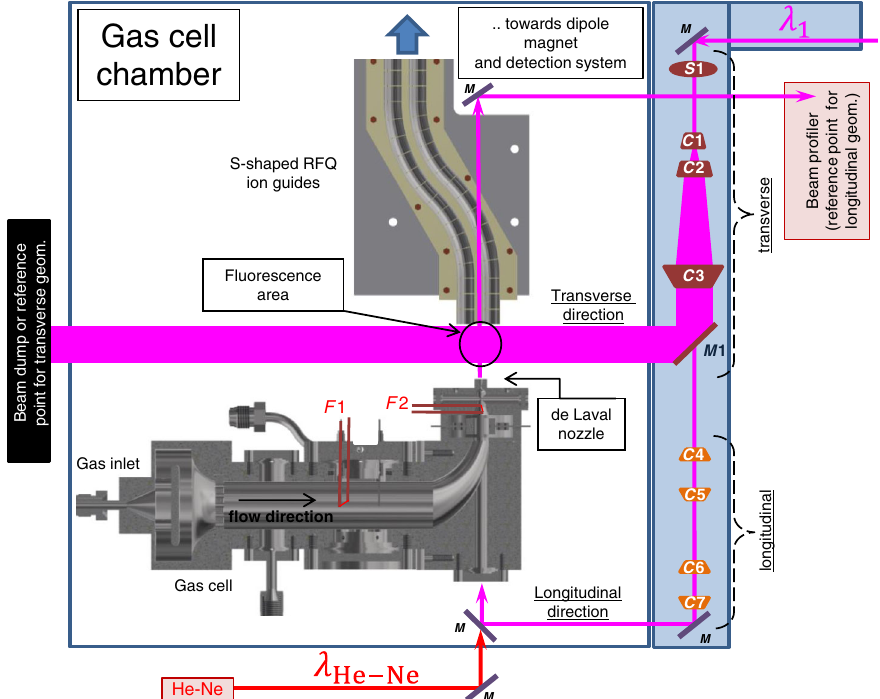
FIG. 2. Layout of the PLIF spectroscopy setup (not to scale). A more detailed layout of the IGLIS laboratory is given in Ref. [46]. Here, λ 1 and λ denote a laser used for PLIF experiments ( λ 1 ¼ 327 . 40 nm) and a helium-neon laser, respectively. F 1 and F 2 He-Ne indicate two tested filament positions. An ICCD camera used in PLIF experiments was oriented normally to the view shown here. M denotes UV mirrors. Transverse direction: S 1 is a spherical lens, C 1 and C 2 are plano-concave cylindrical lenses, and C 3 is a plano-convex cylindrical lens. Longitudinal direction: ð C 4 þ C 5 Þ and ð C 6 þ C 7 Þ are two sets of (plano-concave + plano-convex) cylindrical